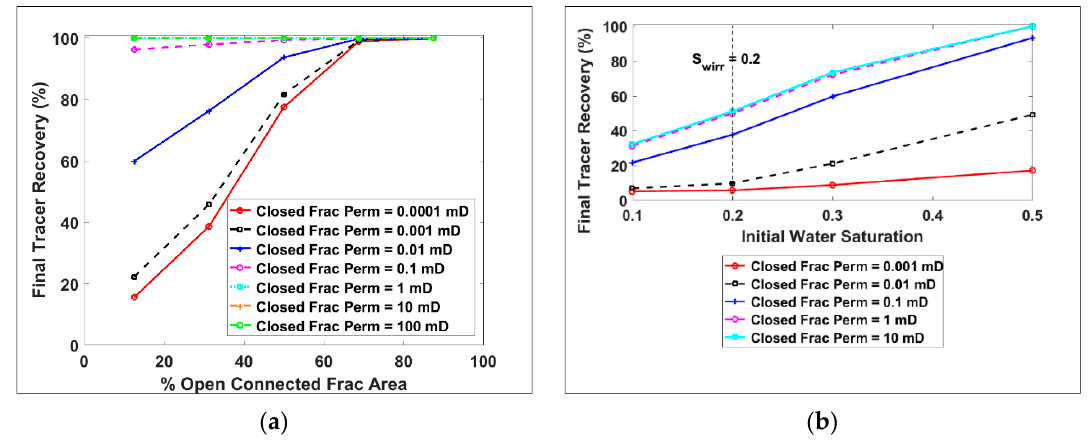
Figure 24. Impact of open connected (F OC ) fracture area on tracer recovery ( a ). Effect of initial water saturation on tracer recovery ( b ).